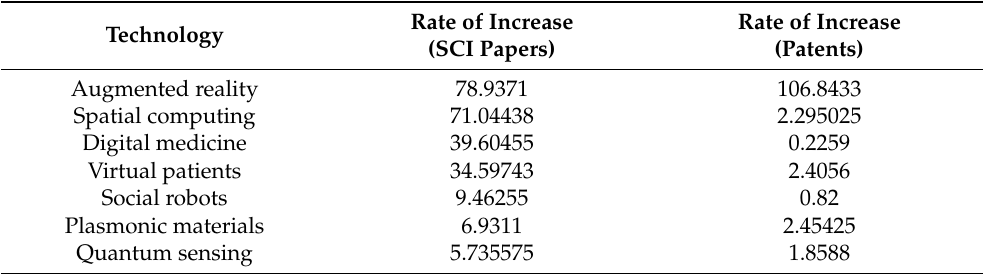
Table 6. Technologies predicted to grow in both number of patents and Science Citation Index (SCI) papers.